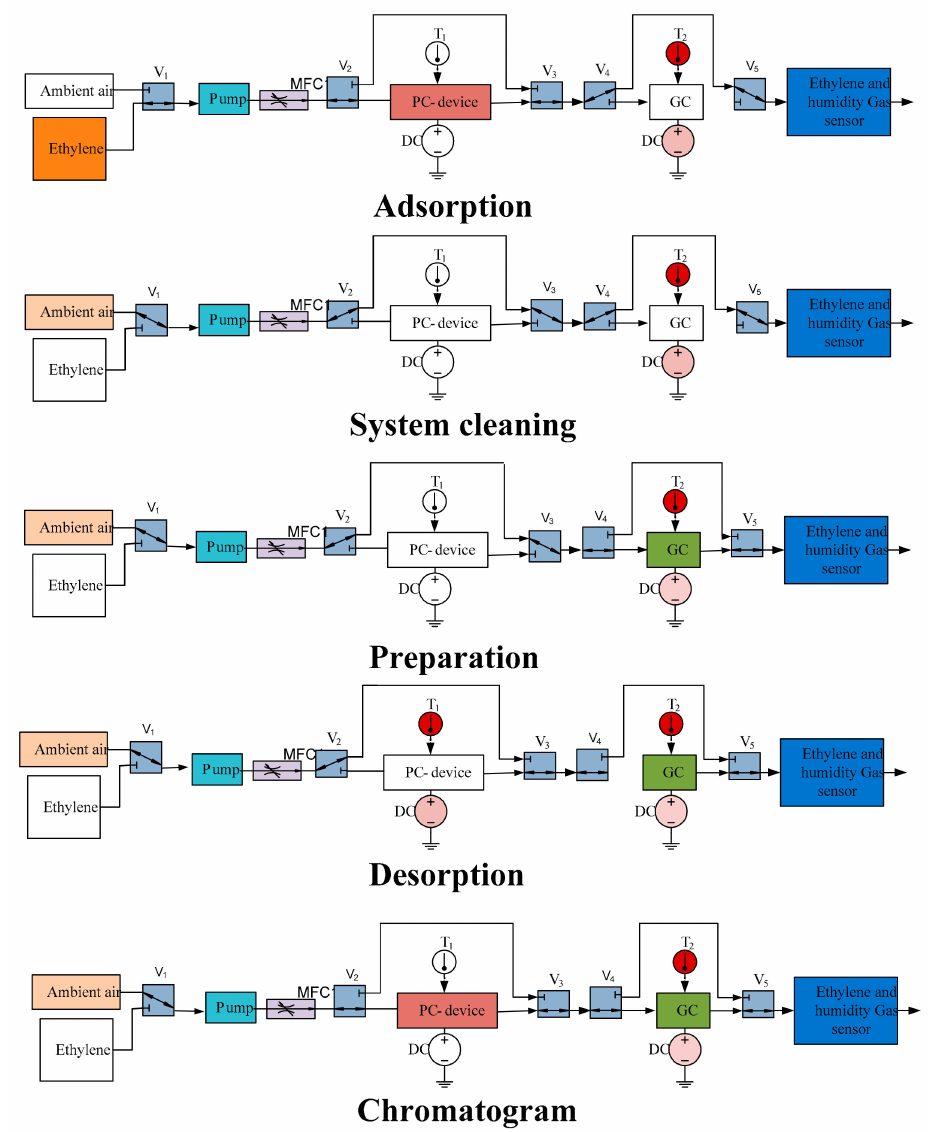
Figure 6. Gas chromatographic system operation. From top to bottom: adsorption, system cleaning, preparation, desorption and chromatographic